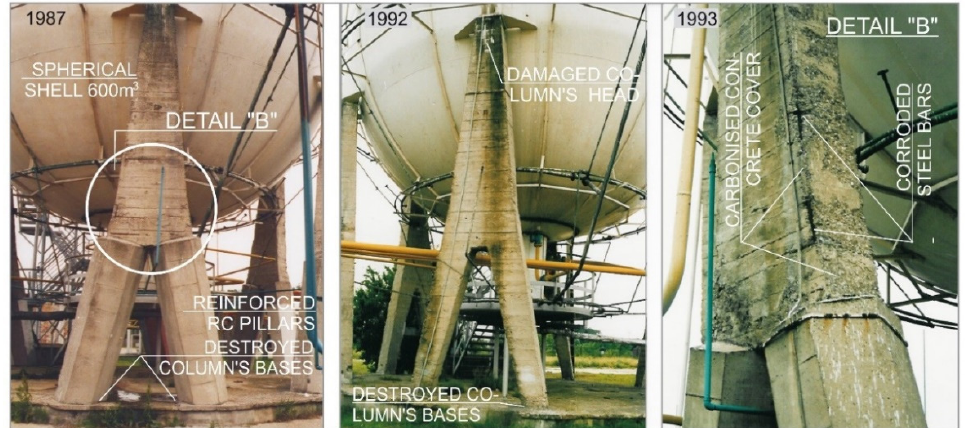
Figure 2. Structural faults of support structures of tanks with a capacity of 600 m 3 .